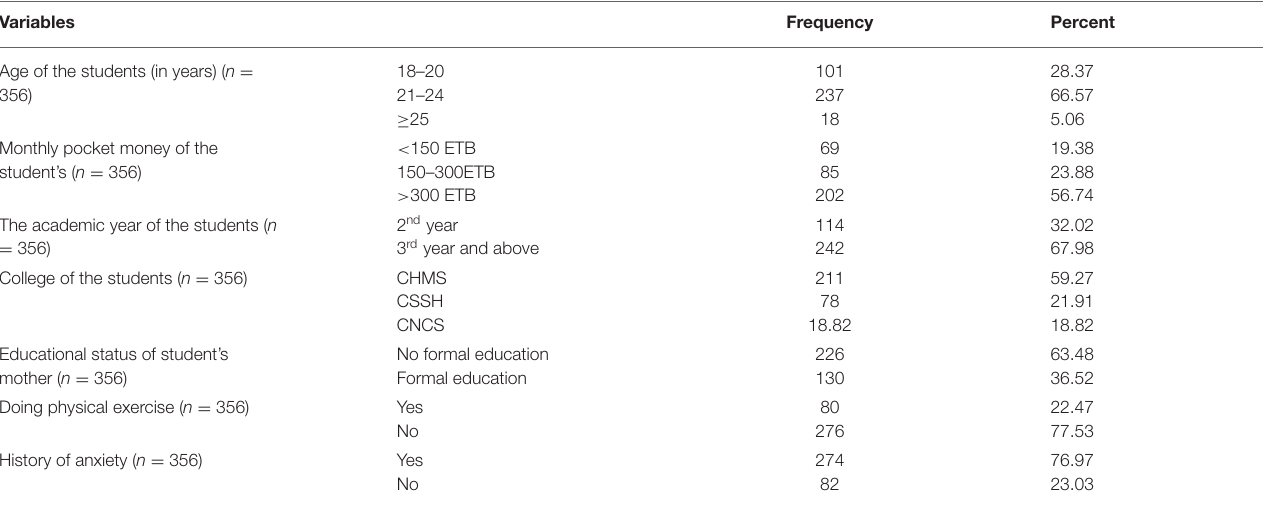
TABLE 1 | Socio-demographic characteristics of female undergraduate students, at Haramaya University, Ethiopia, 2020.